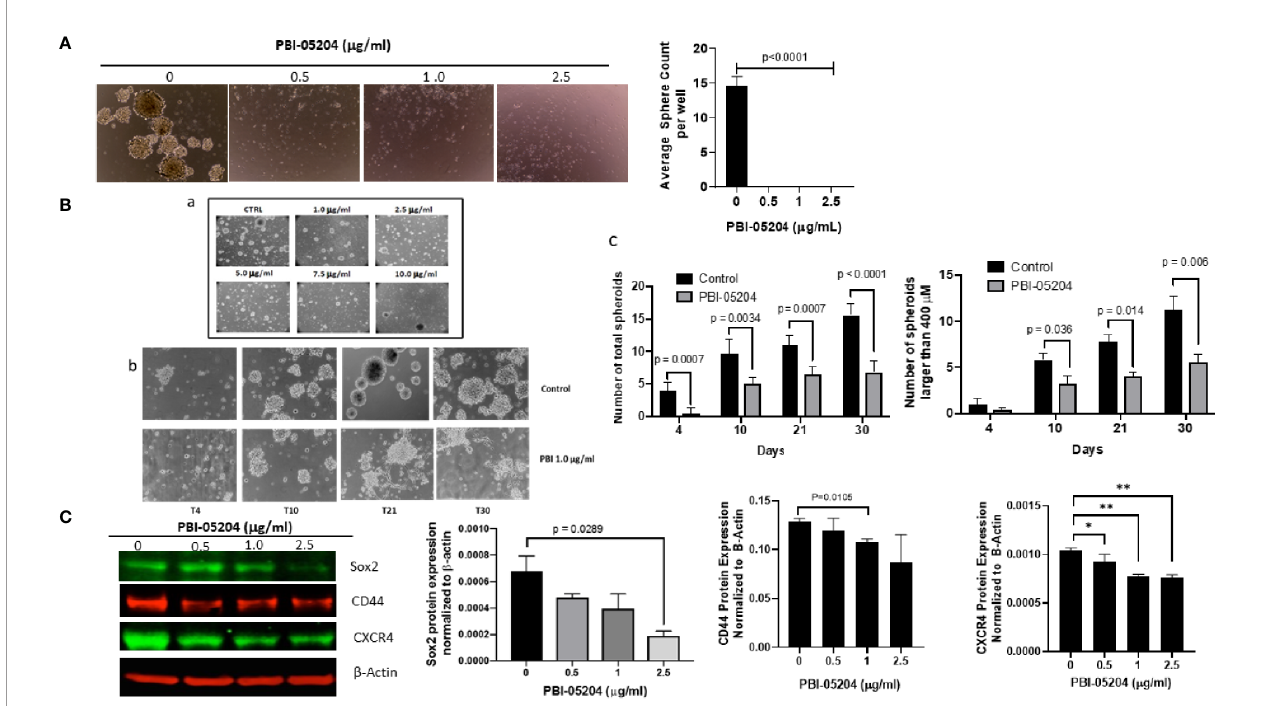
FIGURE 4 | PBI-05204 inhibits GSC self-renewal capacity and expression of stem cell markers in GBM cells. (A) U87 spheroid forming cells were treated with PBI- 05204 for 7 days and spheroid formation in the control, or PBI-05204 – treated wells was determined. Pictures were taken at 20×. Quantitative analysis showed that signi fi cant reductions in spheroid formation in PBI-05204 – treated groups were observed compared to control groups. (B) PBI-05204 administration dose- dependently reduced the number and size of single spheres of BT48EF cells. (a) Spheroid formation in BT48EF cells treated with PBI-05204 (1.0 – 10.0 µg/ml). (b) BT48EF spheroid forming cells were treated with PBI-05204 (1.0 µg/ml) for 30 days. (c) Number of total single spheres and spheres large than 400 µM of BT48EF cells treated with PBI-05204 for 30 days. (C) Protein expression of Sox2, CD44, and CXCR4 in U87 cells after being treated with PBI-05204 for 24 h. Experiments were performed in triplicate. Data are presented as mean ± SD. *p < 0.05, **p < 0.01 versus